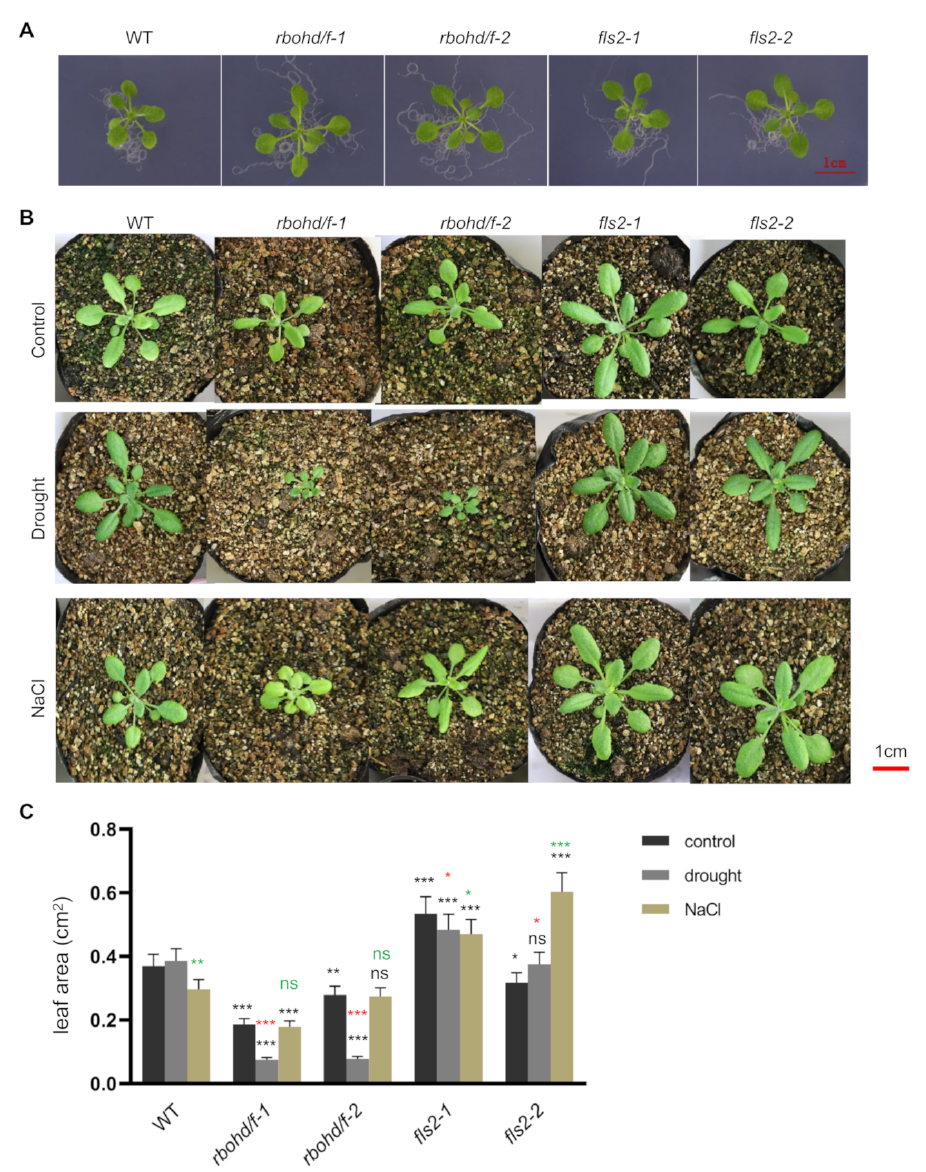
Figure 1. The sensitivity analysis of fls2 mutant and rbohd rbohf double mutant to drought and salt stress. ( A ) The one-week-old seedlings of WT, fls2 and rbohd rbohf double mutants ( rbohd/f ) were grown on 1/2 MS medium plates under normal conditions. ( B ) Two-week-old seedlings of WT and mutants were treated with drought and NaCl for one week, and untreated seedlings were used as controls. Scale bar: 1 cm. ( C ) Statistical analysis of the leaf area of seedlings of WT and mutants in ( B ). The data were analyzed by one-way ANOVA following Brown–Forsythe test. ns: p > 0.05, *: p < 0.05,**: p < 0.01, ***: p < 0.001. The black stars represent the comparison between mutant and WT; red stars represent the comparison between drought and control; green stars represent the comparison between NaCl and